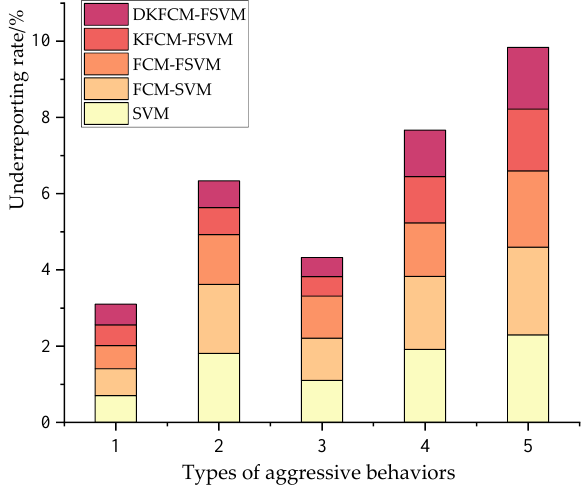
Figure 9. The false negative rate of the wireless sensor network algorithm models.